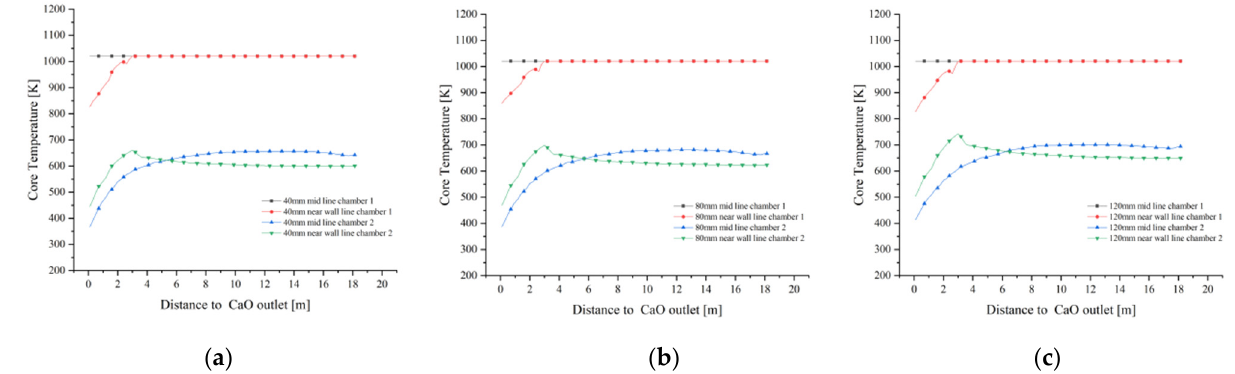
Figure 16. Solid core temperature variation on the mid line and near wall line for 40 mm, 80 mm and 120 mm particle sizes. ( a ) Variation in solid core temperature at 40 mm ( b ) Variation in solid core temperature at 80 mm ( c ) Variation in solid core temperature at 120 mm.